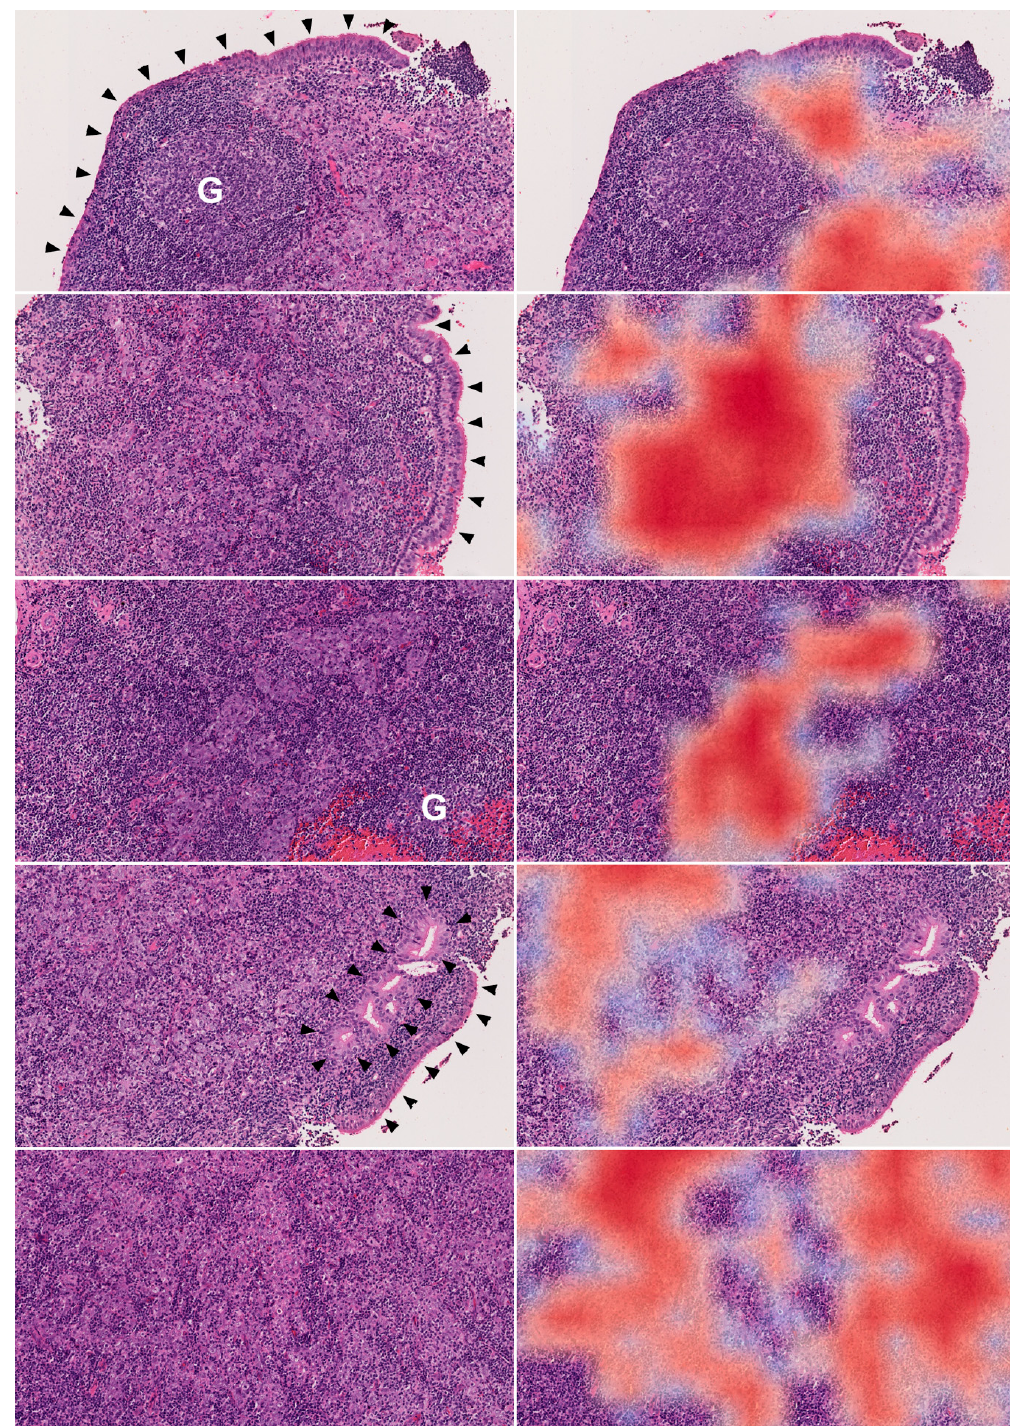
Figure 5. Correlation between our patch-level model and H&E morphology. More examples of nasopharyngeal carcinoma in our testing set. Each right image is derived from the left corresponding H&E image using our patch-level model (original magnification ×100). Despite the large number of admixed lymphocytes, the tumor cells were successfully identified by our patch-level mode (red color: high probability). Note that the germinal centers (G) and benign epithelial cells (arrowheads) were correctly classified as benign.